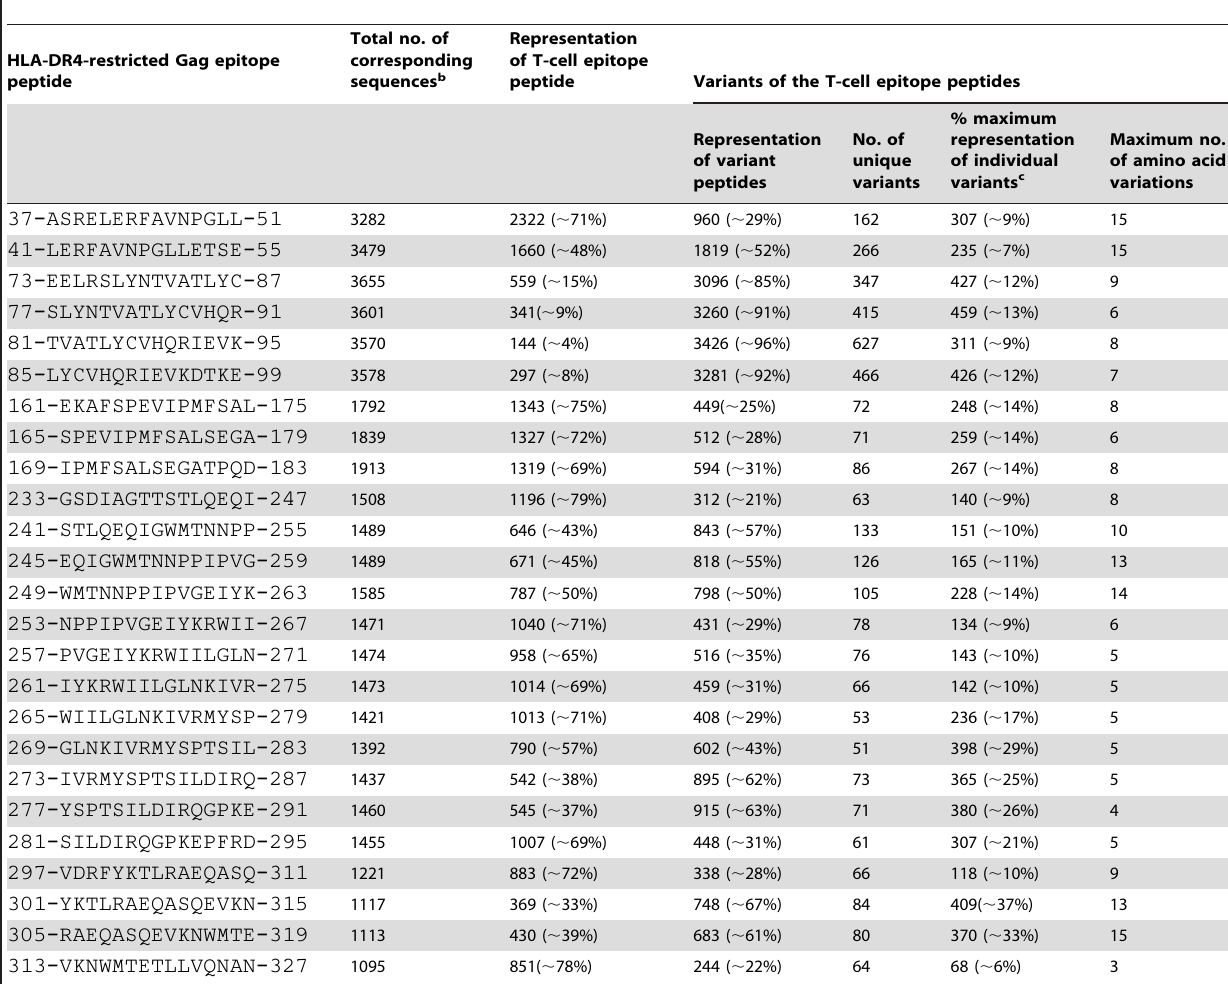
Table 3. Representation of identified DR4-restricted T-cell epitope peptides and their variants in reported human HIV-1 clade B Gag protein sequences, obtained from the NCBI Entrez protein database a .